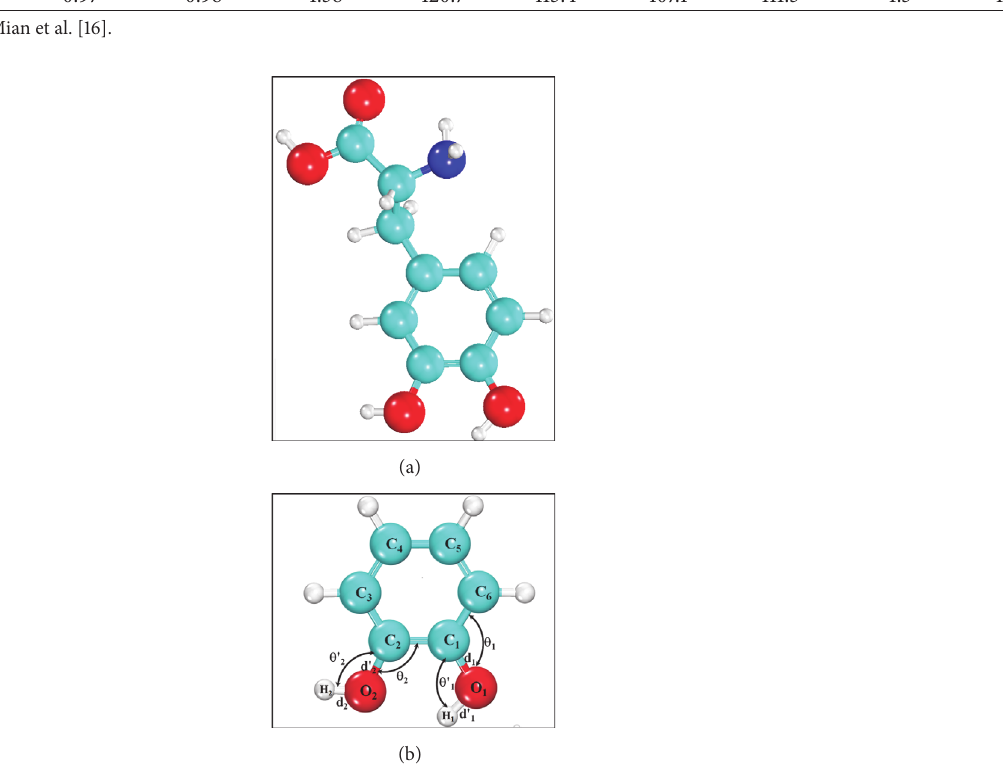
Figure 1: Optimized geometry of L-dopa (a) and its catechol functionality